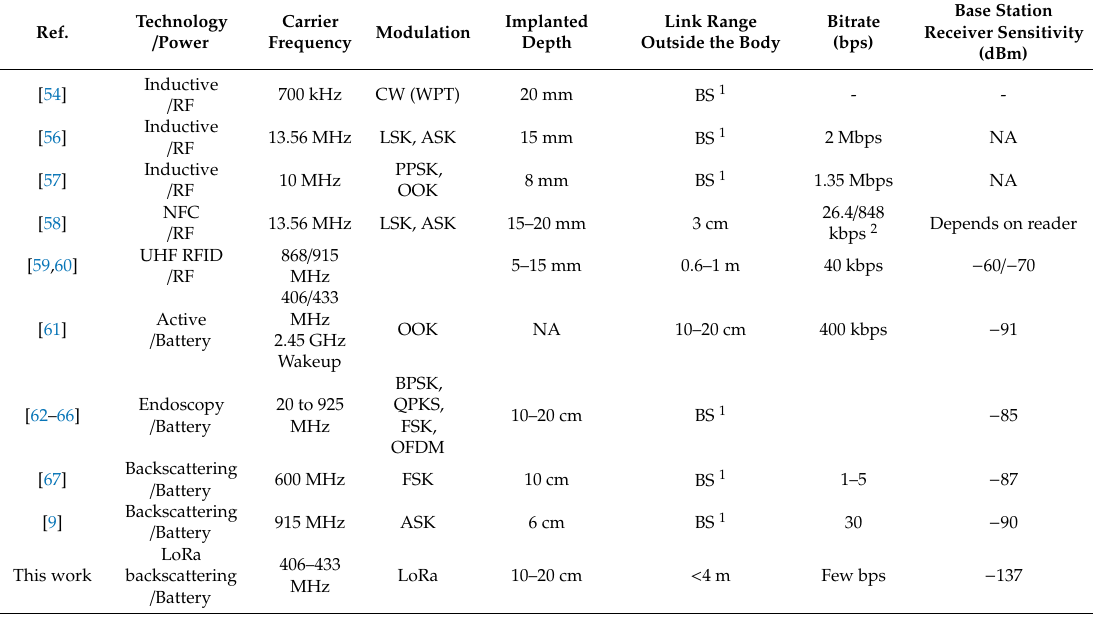
Table 4. Comparison with other communication technologies for implantable medical